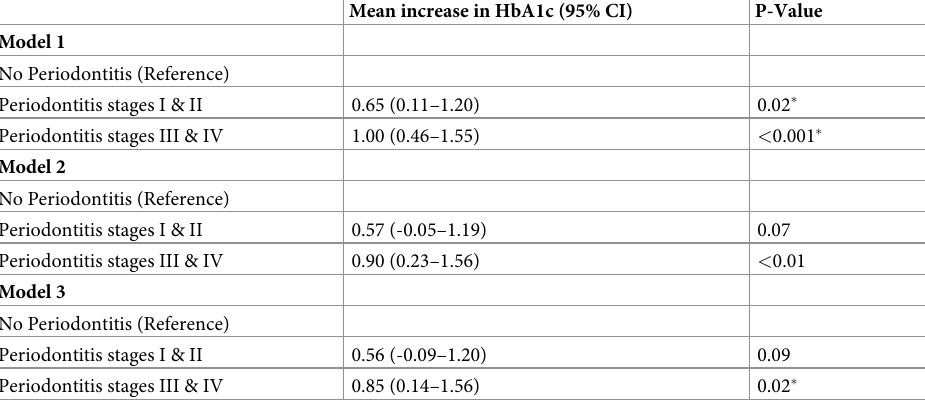
Table 4. Mean increase in HbA1c by periodontal diagnosis (linear